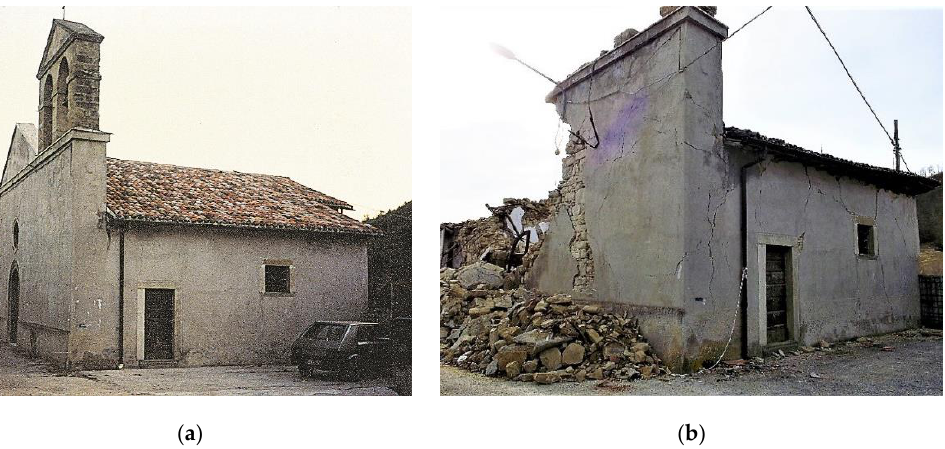
Figure 12. The St. Peter and Paul church in Macchia (Accumoli), before ( a ) and after ( b ) the earthquake occurred on 30 October 2016.